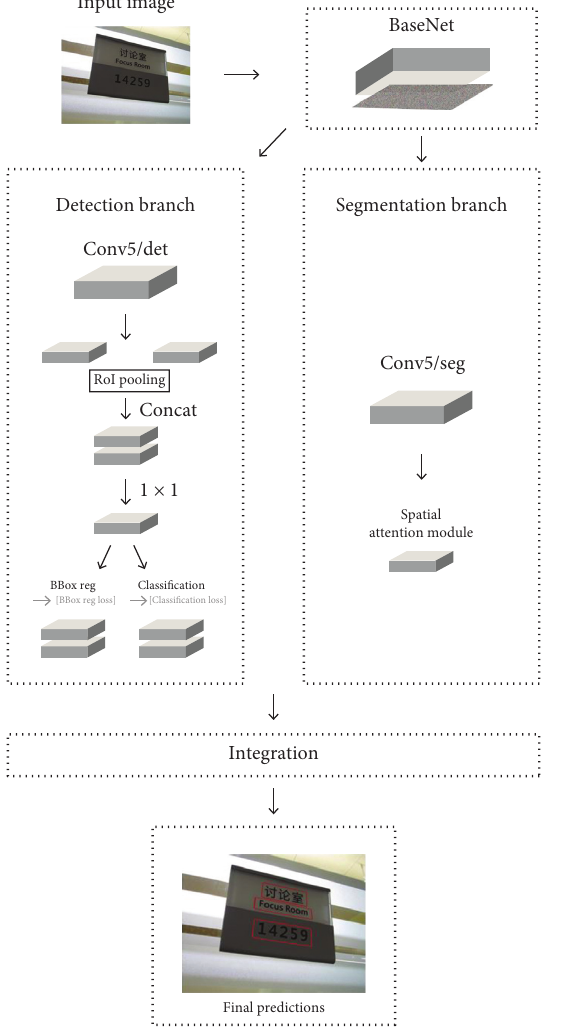
Figure 1: The proposed network structure of